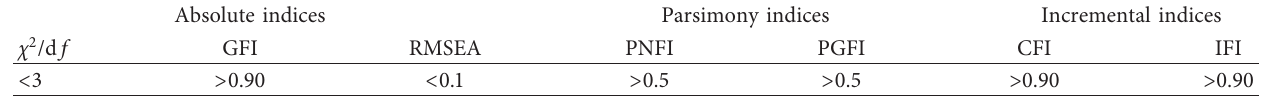
Table 2: Commonly used model fitting